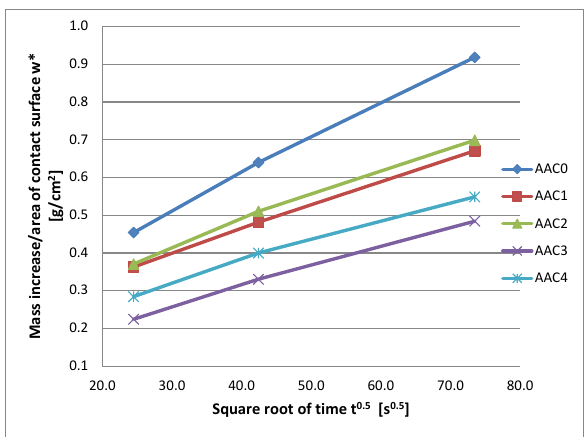
Figure 2. Capillary water absorption of AAC specimens (cumulative absorption w * versus t 0.5 ) Figure 2: Capillary water absorption of AAC specimens (cumulative depending on gypsum content absorption w * versus t 0.5 ) depending on gypsum content Figure 3. Capillary rise of AAC specimens depending on gypsum content Figure 3: Capillary rise of AAC specimens depending on gypsum content creased by approximately 40% compared to the control samples.